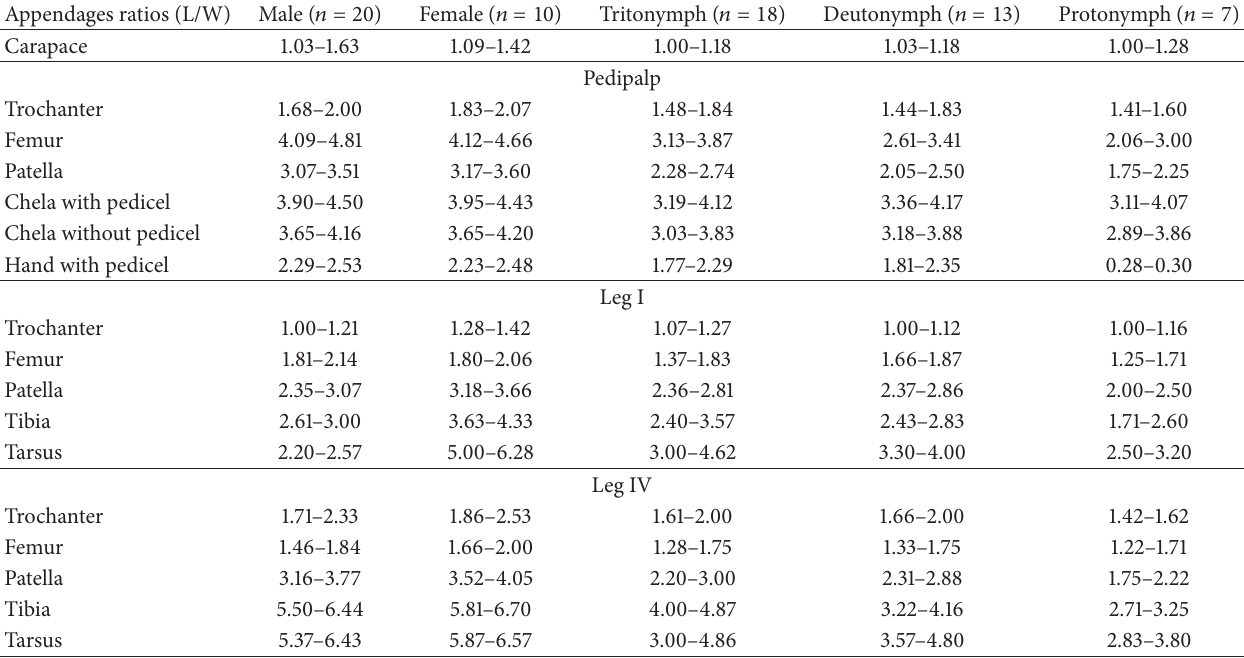
Table 2: The ratios of morphological characters in Dactylochelifer gracilis .